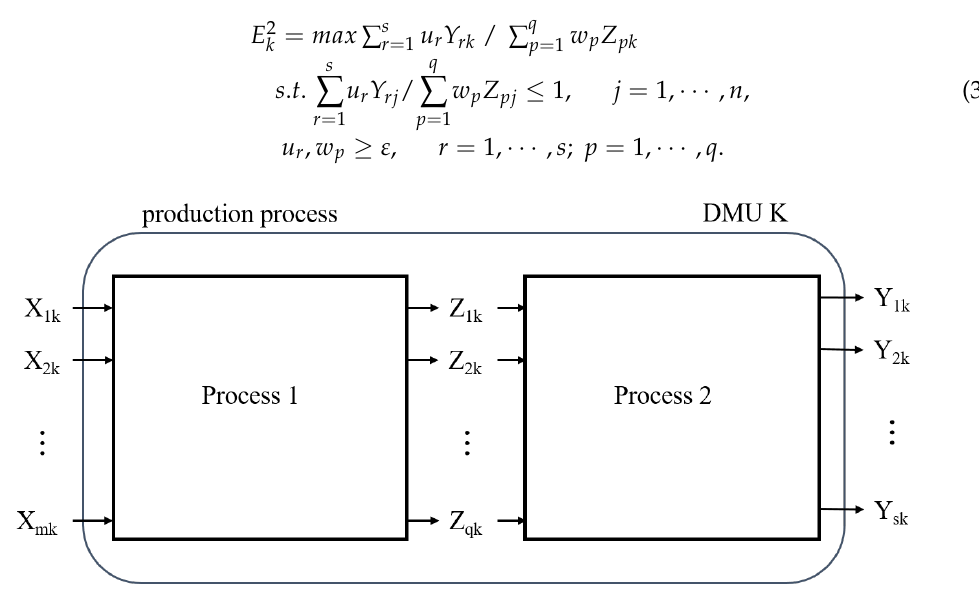
Figure 1. Two-stage DEA model.